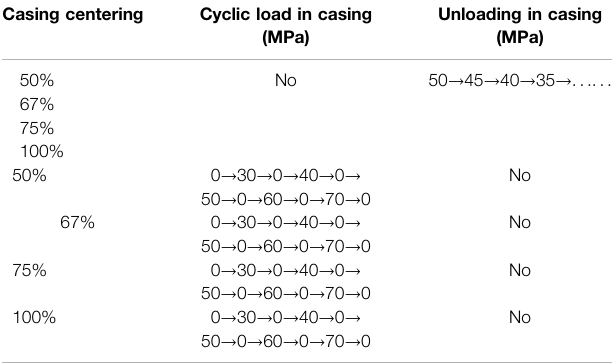
TABLE 4 | Effect of casing eccentricity on cement sheath seal failure. Casing centering